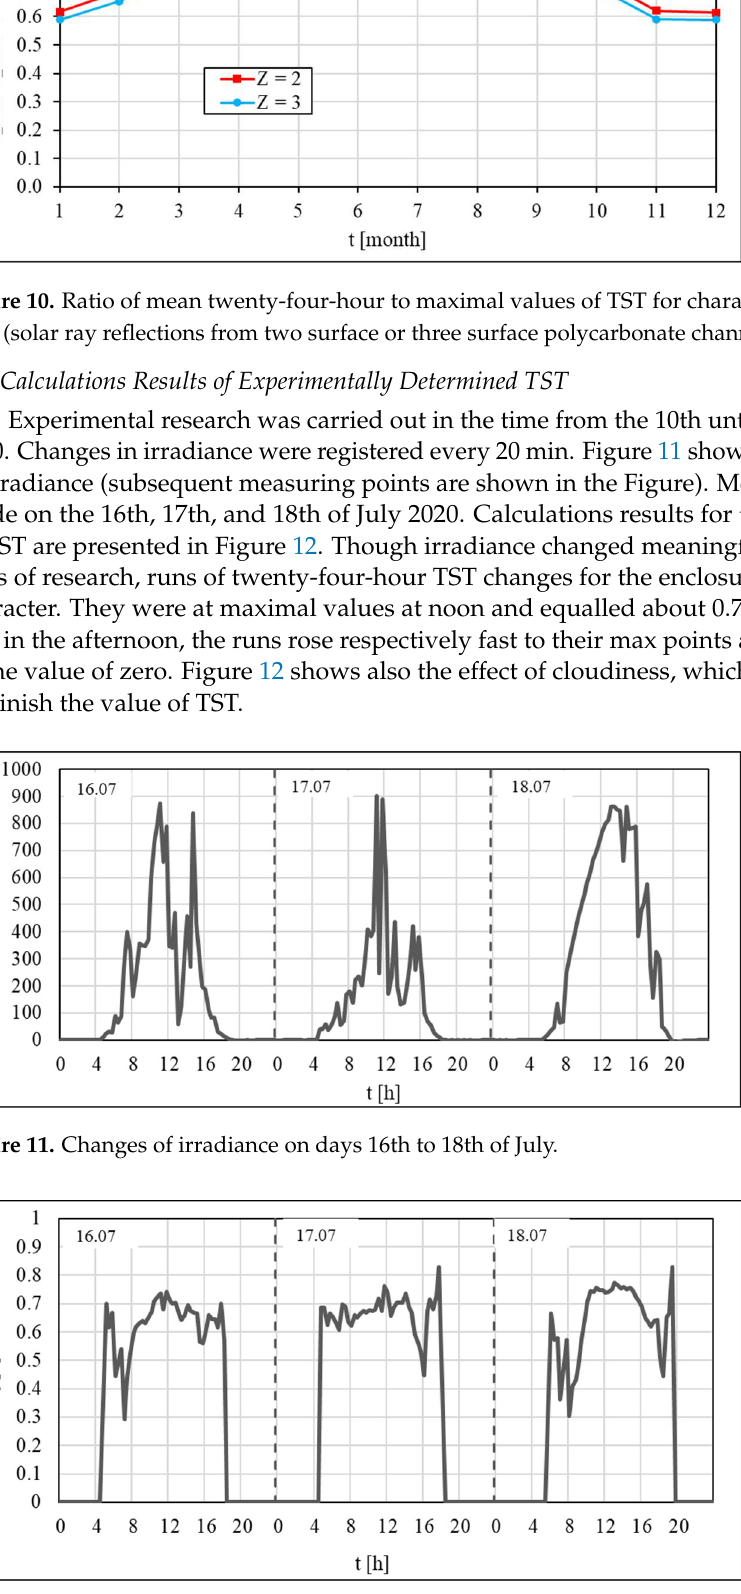
Figure 12. Changes of TST for enclosure under research on days 16th to 18th of July.